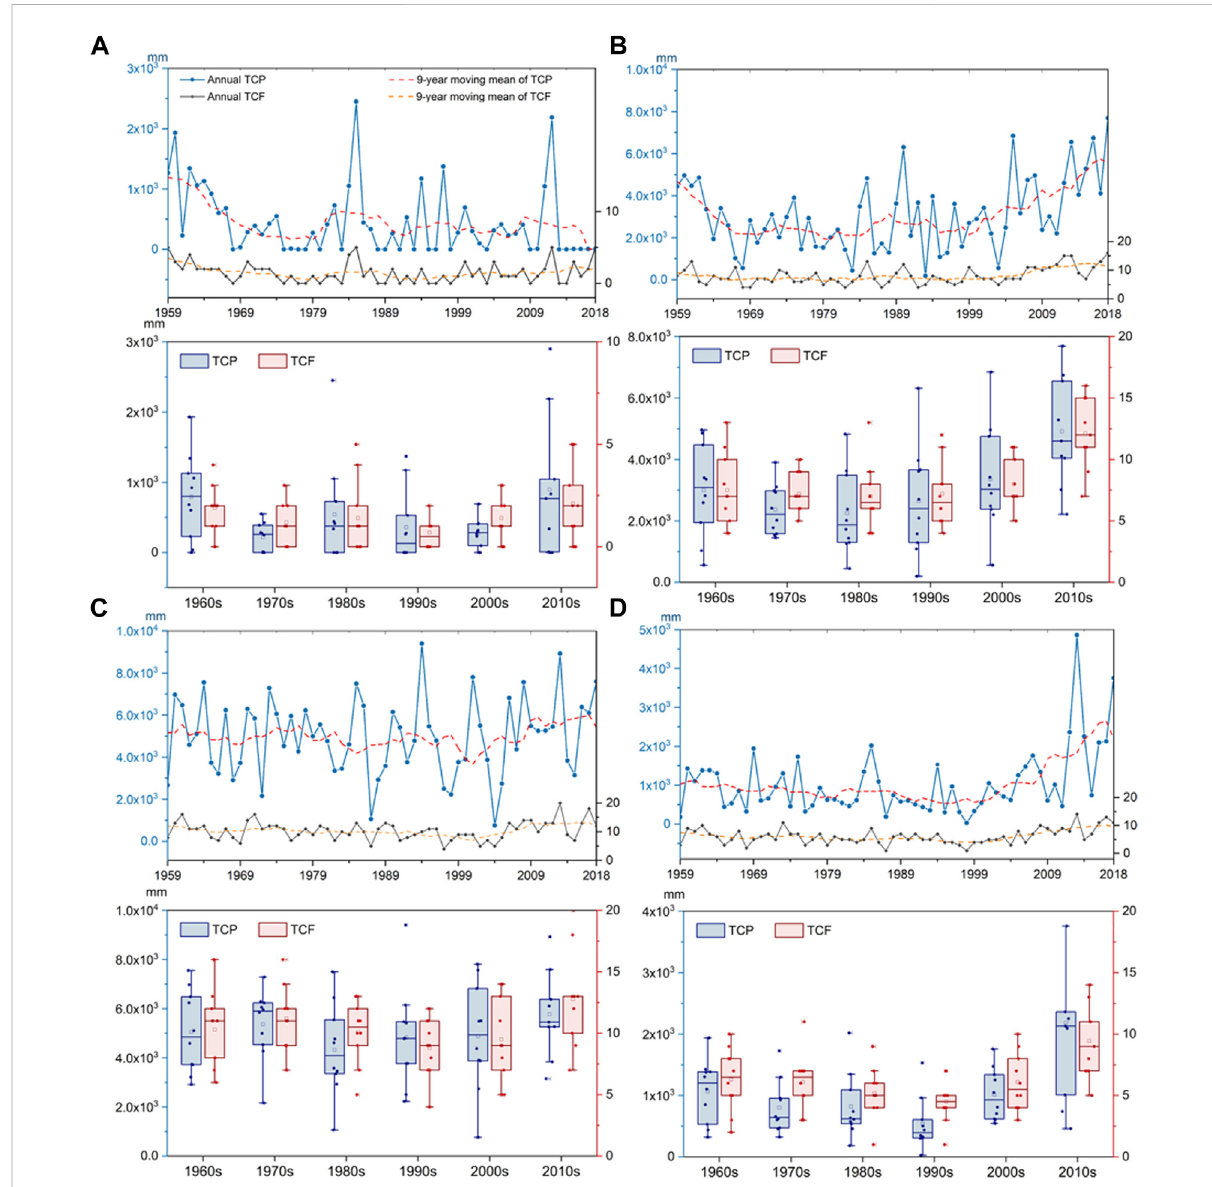
FIGURE 12 Interdecadal TCF and TCP in subregions over China: (A) northeastern China, (B) eastern China, (C) southern China, and (D) inland areas.